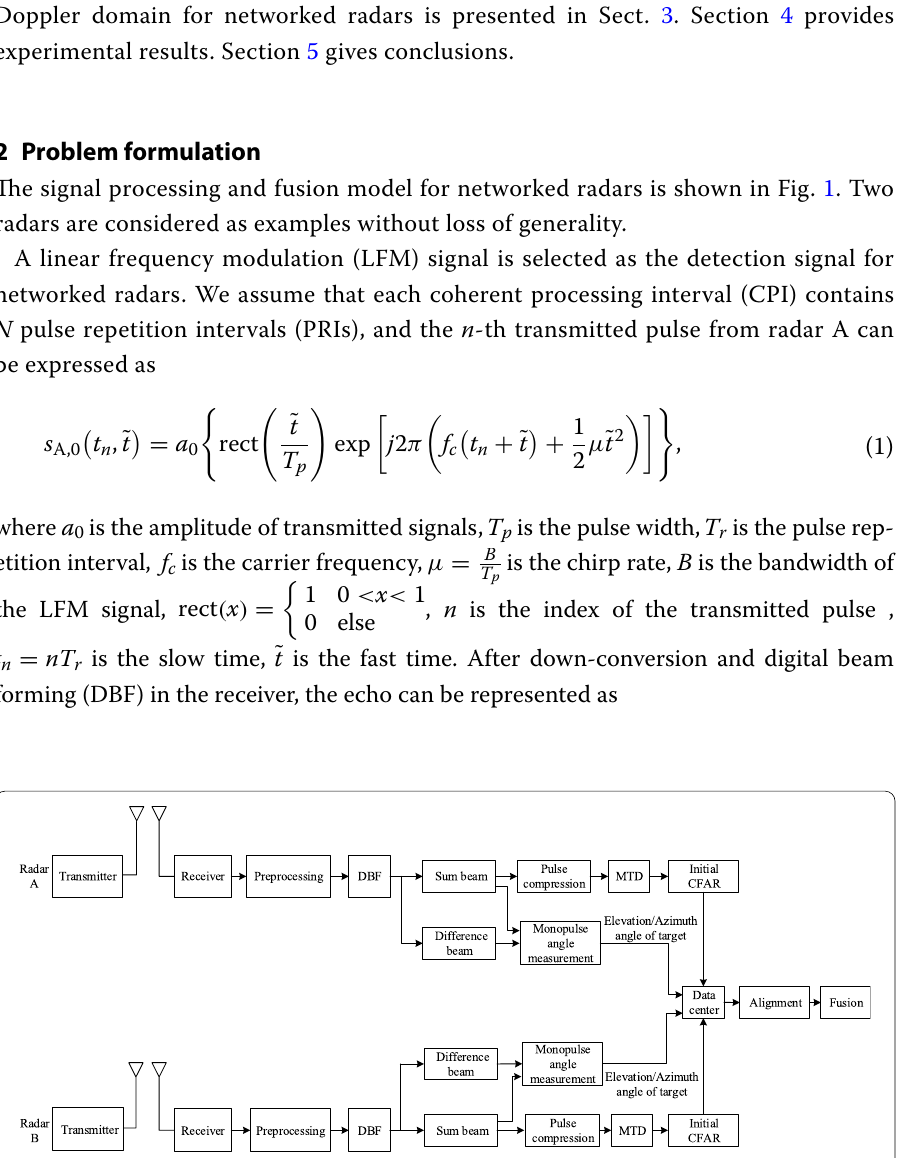
Fig. 1 The signal processing and fusion model for networked